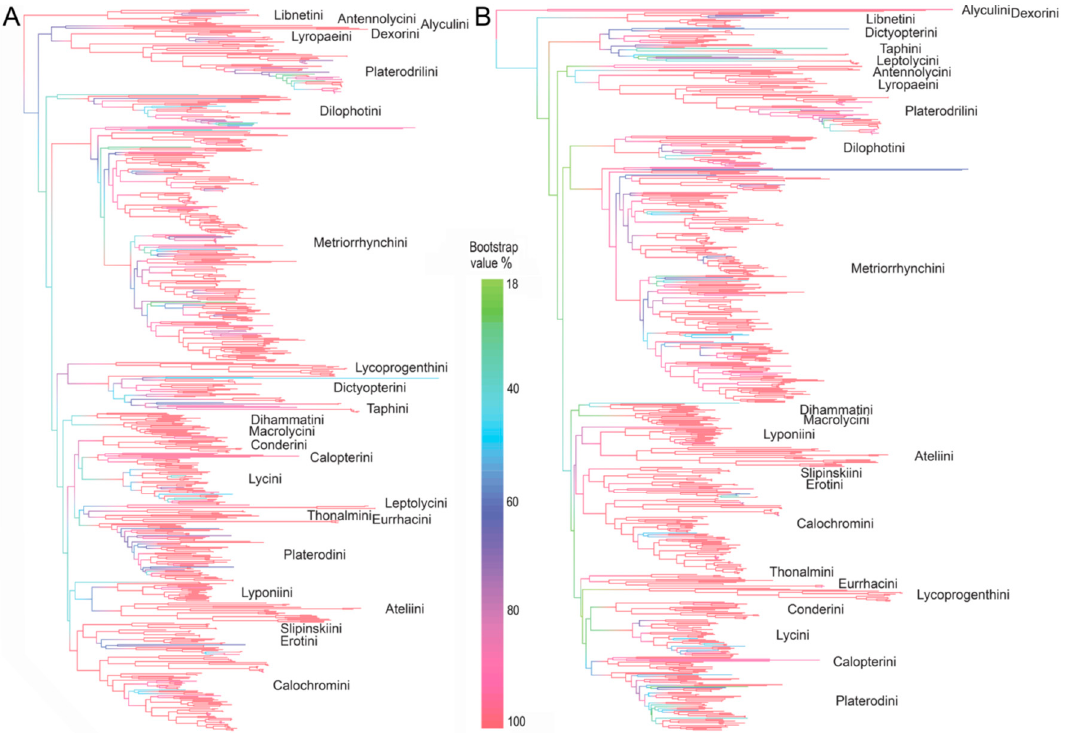
Figure 2. The maximum likelihood IQ-TREE topology. ( A ) Tree inferred from the complete dataset and 89-taxa outgroup; ( B ) tree inferred from the same dataset and a single outgroup (Iberobaeniidae). Colors designate a level of the bootstrap support; outgroups omitted.